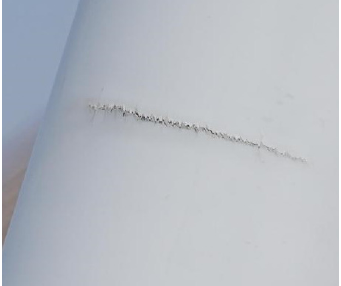
Figure 3. Photo of the micro-cracking on the blade [30].